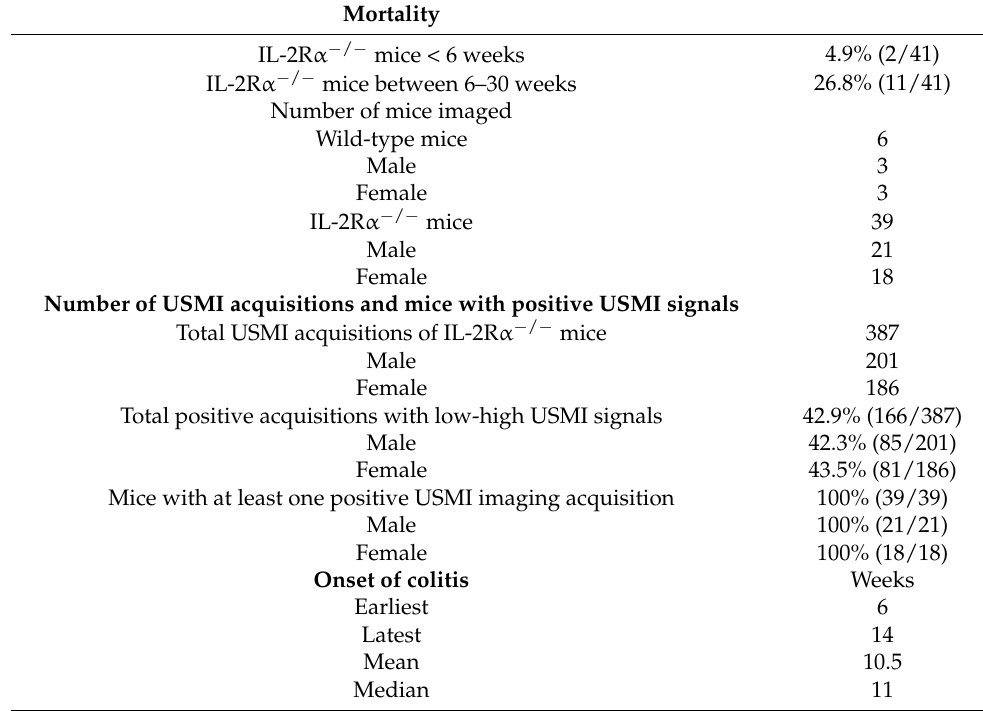
Table 1. Mortality, frequency and onset of colitis in IL-2R α − / −